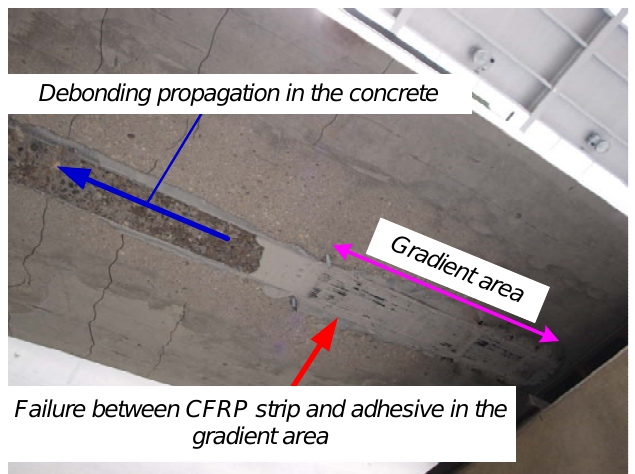
Figure 8. Debonding failure between the CFRP strip and the epoxy adhesive in the gradient anchorage zone.